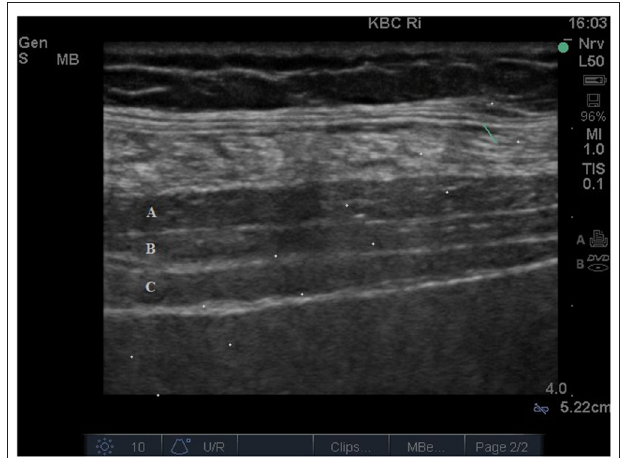
FIGURE 1 | Ultrasound image showing all three muscles of the abdominal wall: (A) external oblique, (B) internal oblique and (C) transversus abdominis muscle.